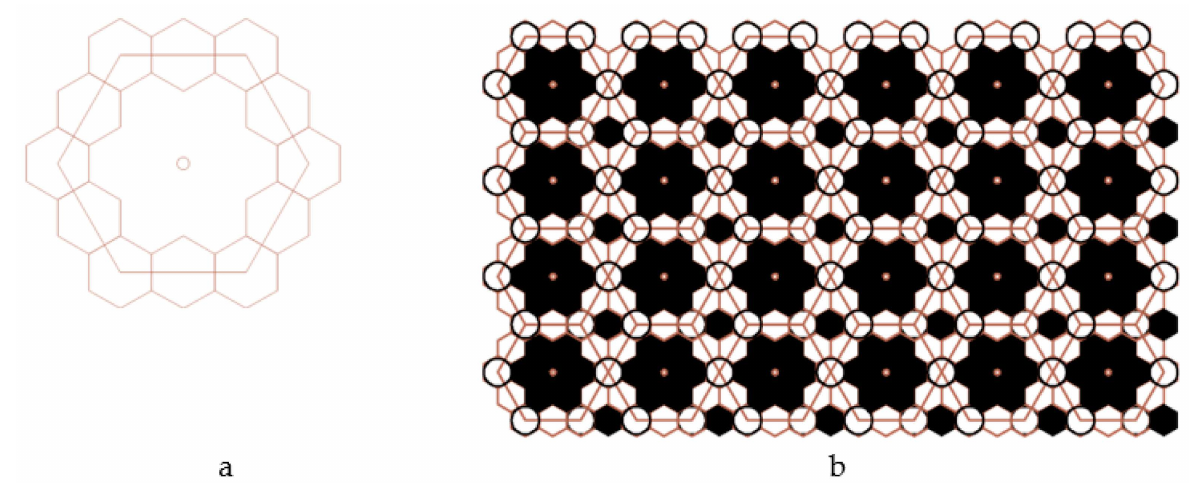
todesk (Figure 9b).